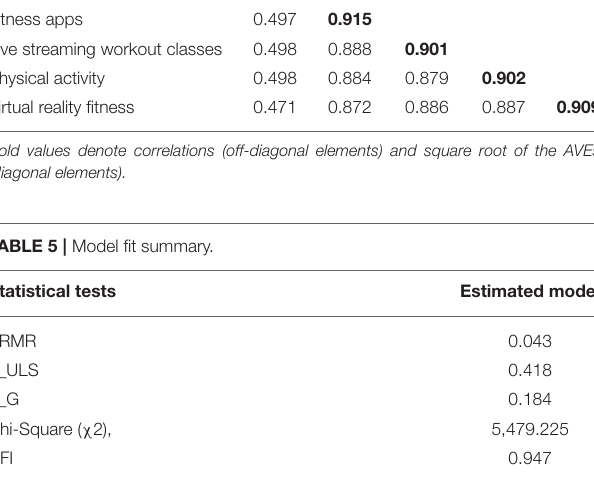
the proposed hypothesis based on the significance level (5% level) of relationships13. Six direct and four indirect assumptions are presented in the structural model, and the structural model was examined by employing the bootstrapping method (See Table 6 ). The results for the proposed hypotheses are presented in Table 5 with path coefficients ( β ), P -values, and T